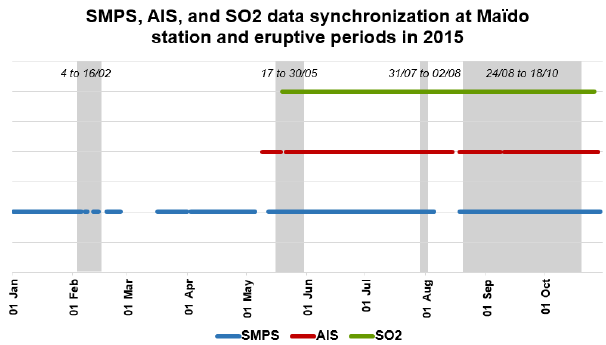
Figure 2. Data coverage of instrumentation for the characterisa- tion of new particle formation events during the eruption periods (in grey) in